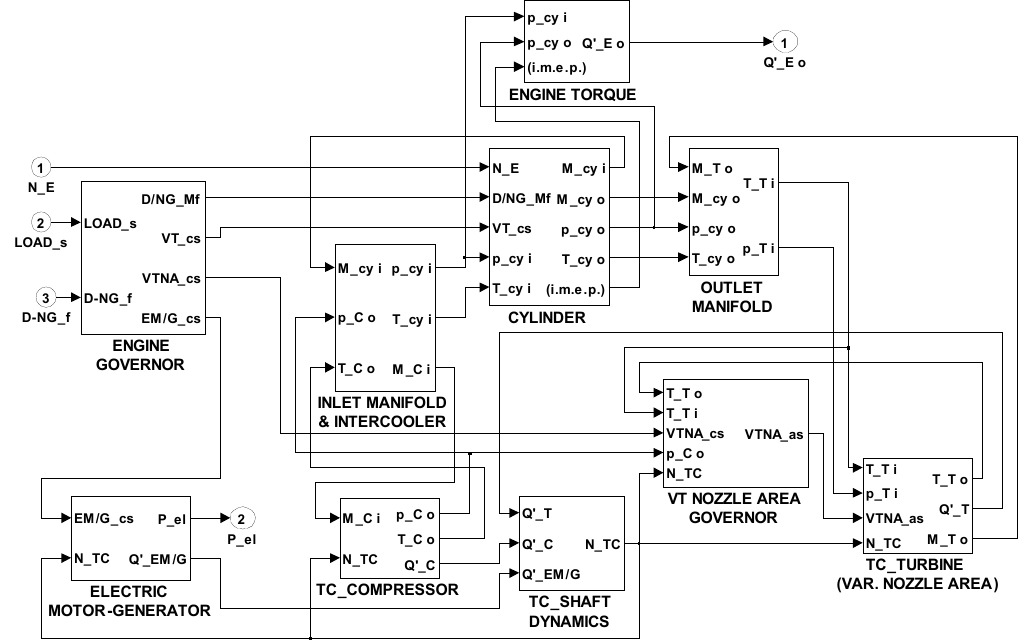
Figure 3. SIMULINK scheme of the MAN 51/60 DF 12V engine simulator (with hybrid turbocharger).